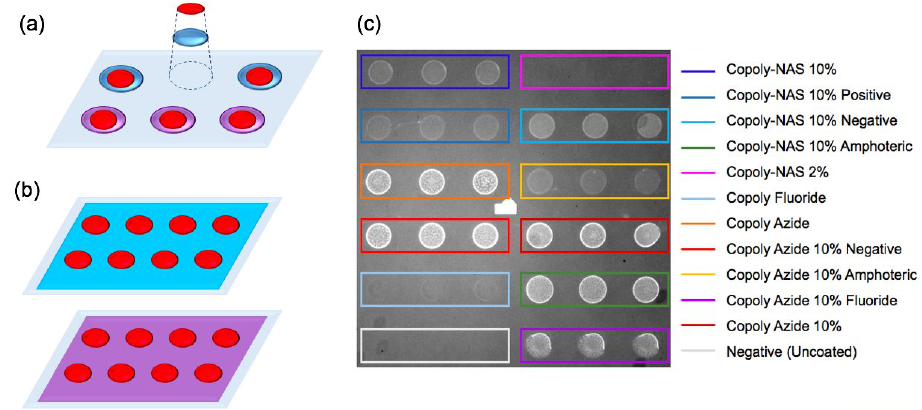
Figure 7. Localized surface chemistry technique. ( a ) On the left, a simplified scheme of the method compared to ( b ) the flat coating technique. The purple and blue surfaces represent different surface chemistries. The red circles represent spots of immobilized molecules. ( c ) On the right, an image of the chip acquired on the IRIS. On the chip, a 6 × 6 matrix of α -Lactalbumin spots is visible. Each group of three spots corresponds to a different polymer, as reported in the legend on the right. Figure reproduced with permission from [104] (Copyright 2019 Springer-Verlag GmbH Germany, part of Springer